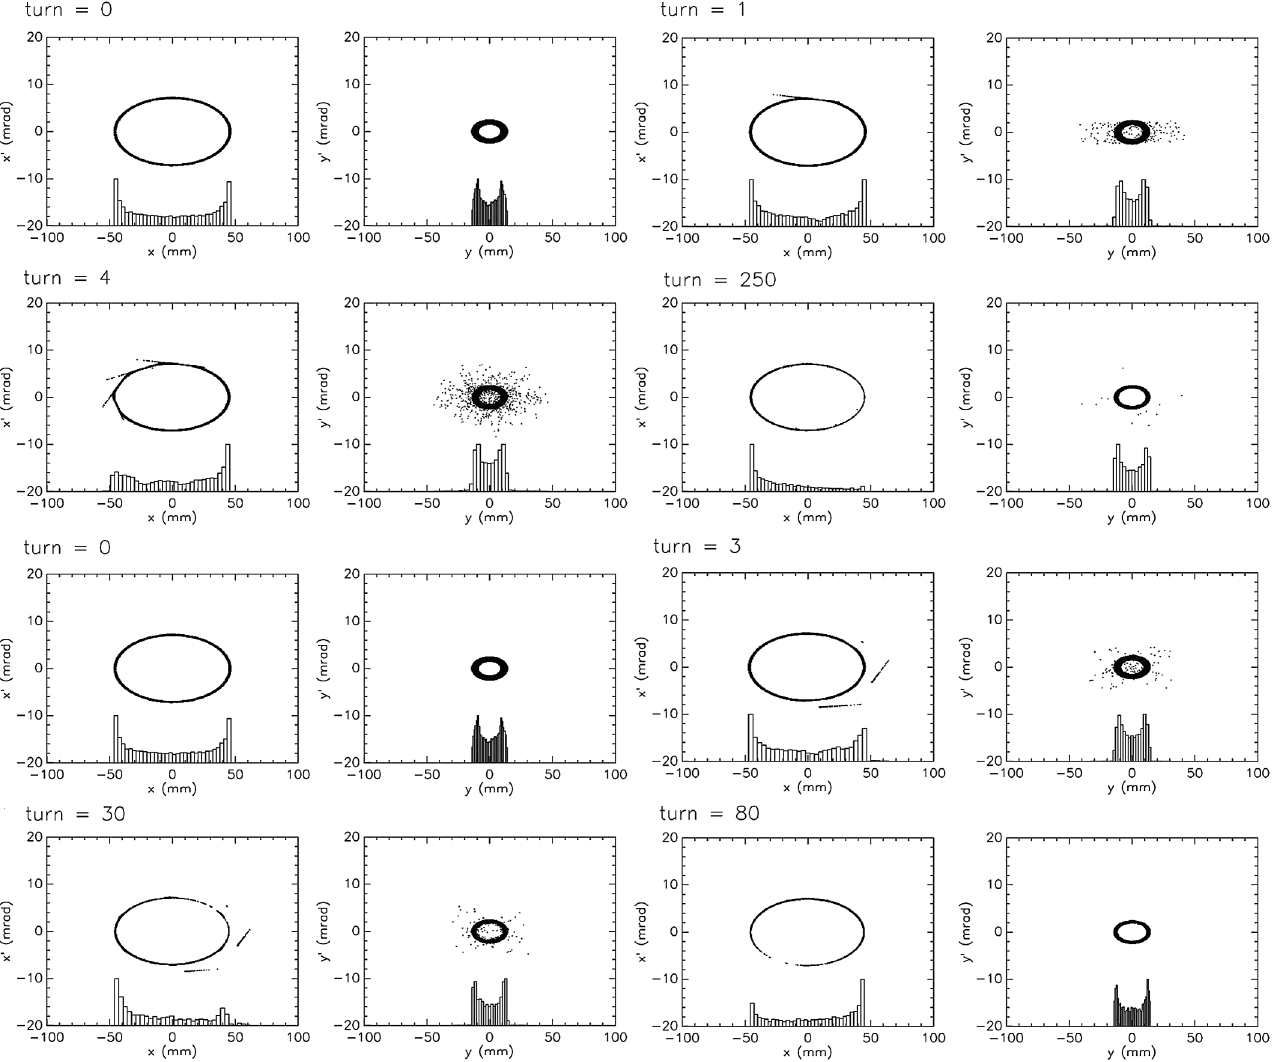
FIG. 5. Beam distributions at the middle point of the dispersion-free long straight section at different turns during the halo collimation of an anticorrelated beam at 80 MeV. Each pair of plots with one in the horizontal plane and the other in the vertical planes corresponds to the given turn. Upper part (four pairs): (cid:1) ¼ (cid:1) 1 : 03% ; lower part (four pairs): (cid:1) ¼ 1 : 03%